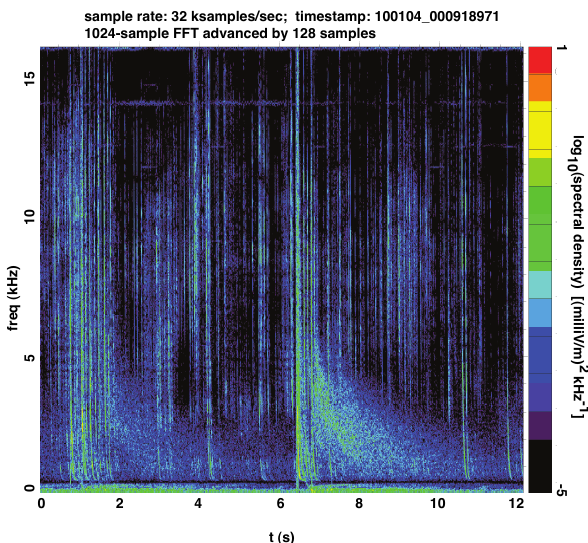
Fig. 1. Spectral density of electric field on antenna pair 3/4 ver- sus time, during the first ∼ 12-s-duration burst recording of 4 Jan- uary 2010, with sampling rate ∼ 32ksampless − 1 . The FFT win- dow is 1024 samples wide, advanced by 128 samples. This record will be dissected into 45 windows, each containing 16384 samples, and overlapping by 8192 samples, for dispersion and peak-finding